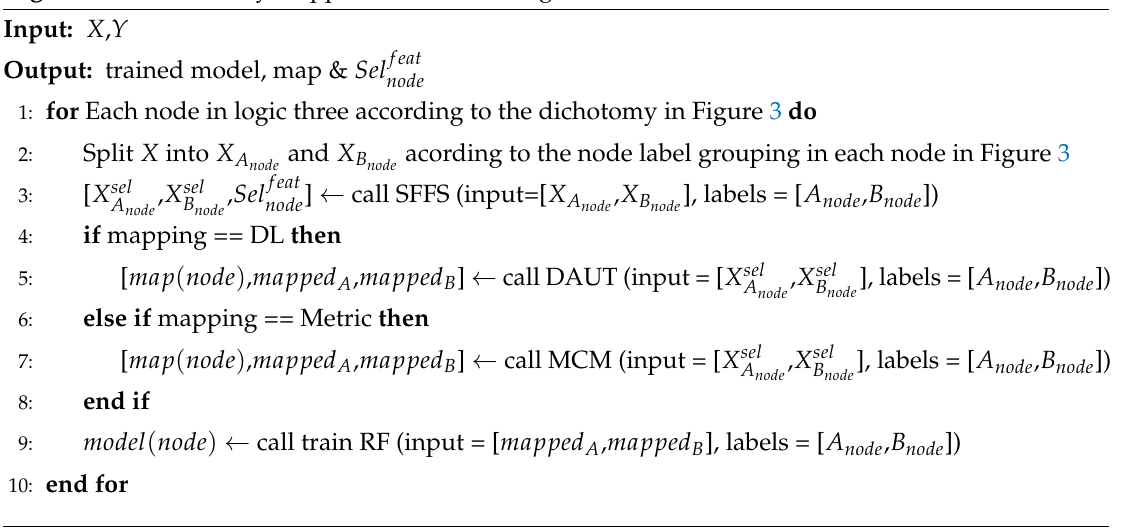
Algorithm 1 Dichotomy mapped forest—Training